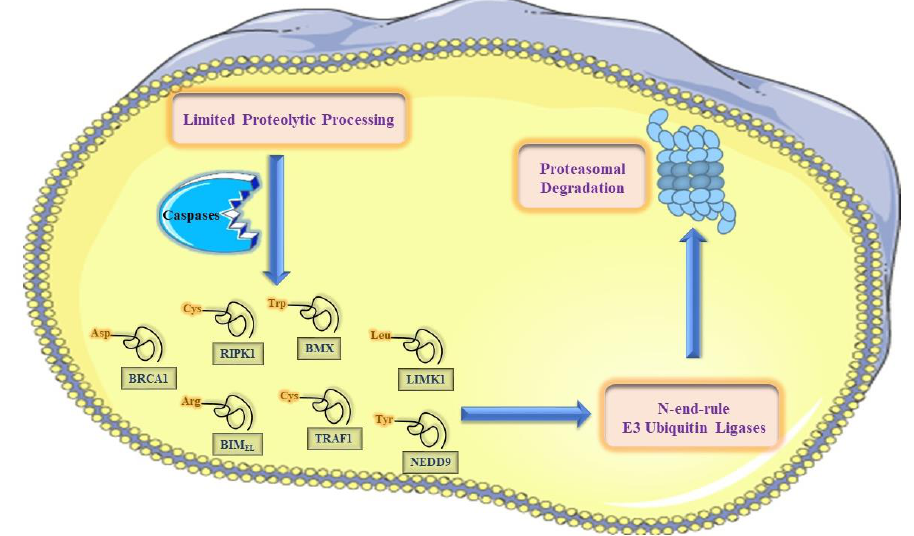
Figure 7. Schematic depiction of the anti-apoptotic role of the Arg/N-end rule pathway via targeted degradation of several pro-apoptotic protein fragments during induction of apoptosis in the context of apoptotic cell death signaling. In addition to other antiapoptotic pathways, the selective degradation of proapoptotic protein fragments via the Arg/N-end rule pathway curbs transient or otherwise unscheduled apoptotic signaling from reaching the point of cellular demise. All the indicated pro-apoptotic fragments have been described in detail in references 10 and 120 .